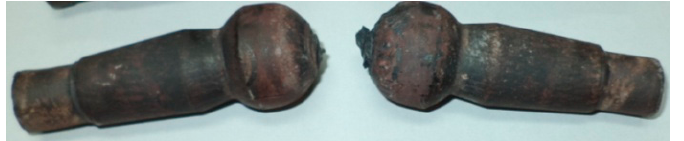
Figure 4. Ball studs obtained by: ( a ) cross-wedge rolling (CWR); ( b ) helical-wedge rolling (HWR).